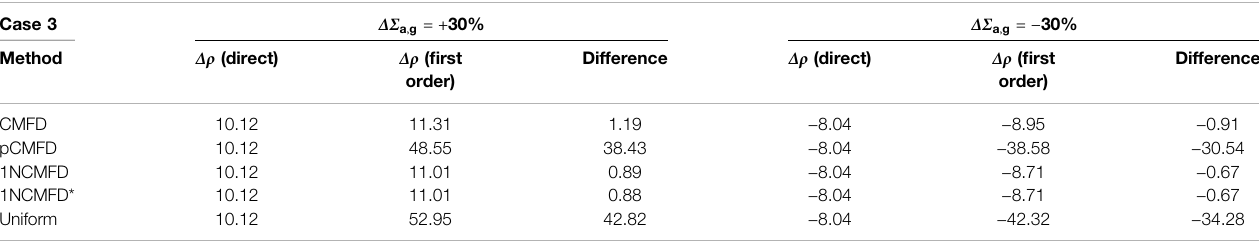
TABLE 7 | Reactivity change (pcm) estimation for perturbation case 3.